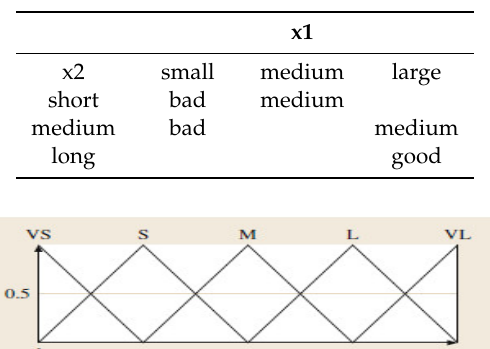
Table 1. Sample decision table.